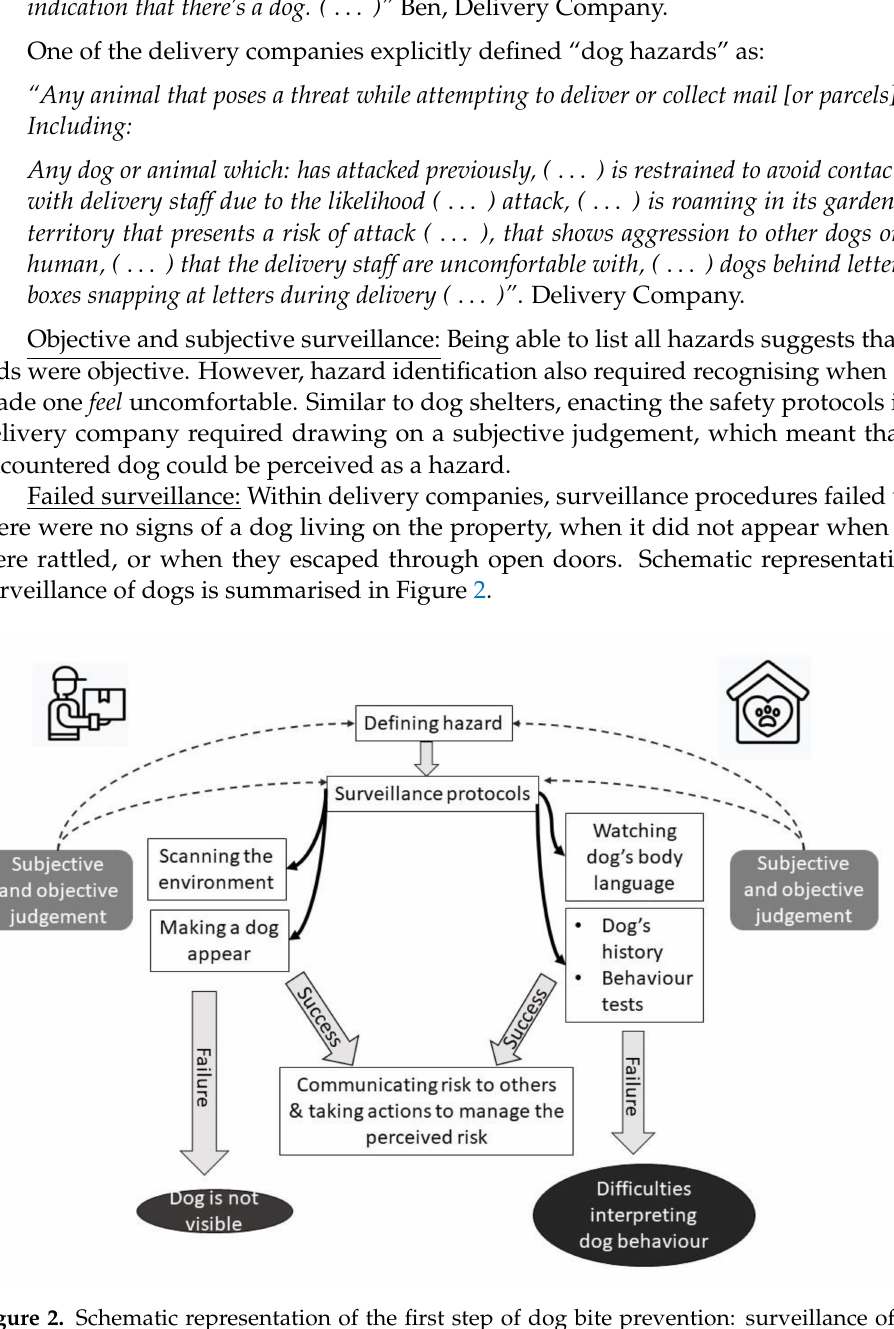
Figure 2. Schematic representation of the first step of dog bite prevention: surveillance of dogs: identifying the risk. In delivery companies and dog shelters, surveillance protocols depend on how the hazard is defined. The actual protocols take different forms in different organizations, however in both shelters and delivery companies, they are informed by both subjective and objective judgement. Successful implementation of surveillance protocols makes communicating risk to others possible. The protocols fail when a dog is not visible or their behaviour cannot be easily